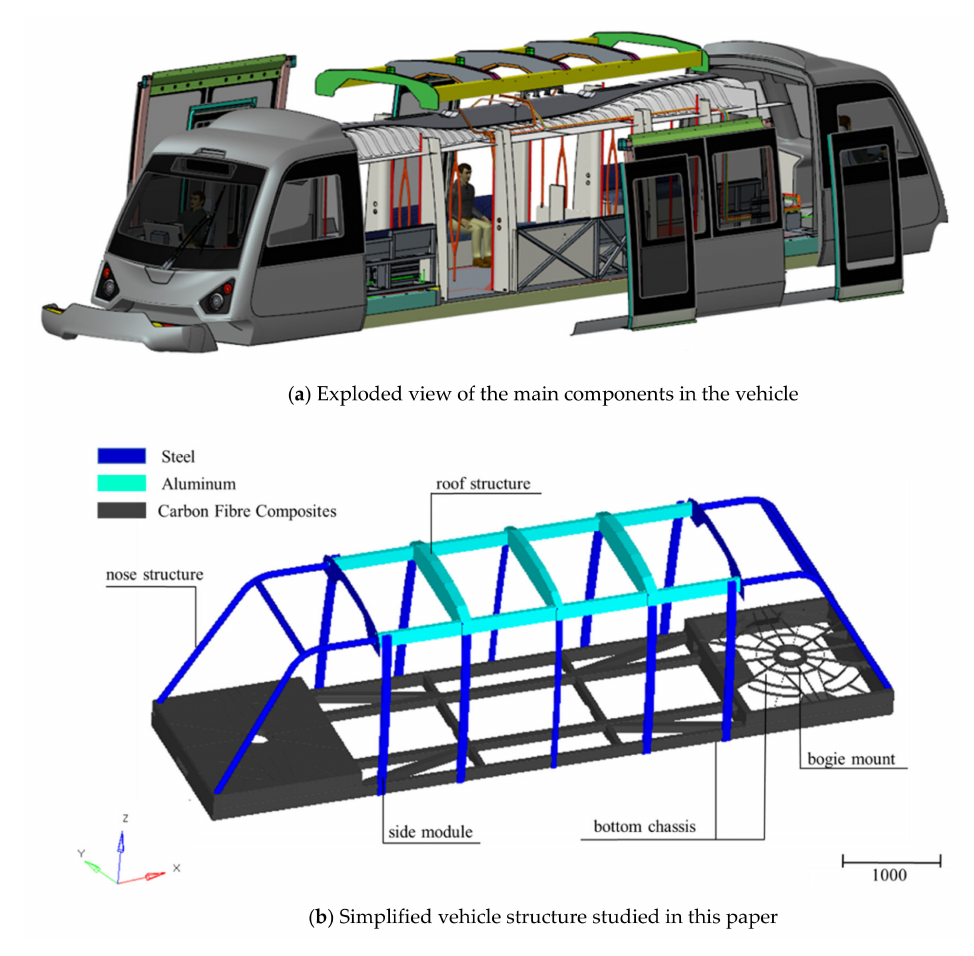
Figure 2. ( a ) Exploded view of the main components in the rail vehicle; ( b ) multi-material design of a simplified light rail vehicle structure. Units in mm. The vehicle length, width and height are 11.0, 2.7 and 3.1 m,